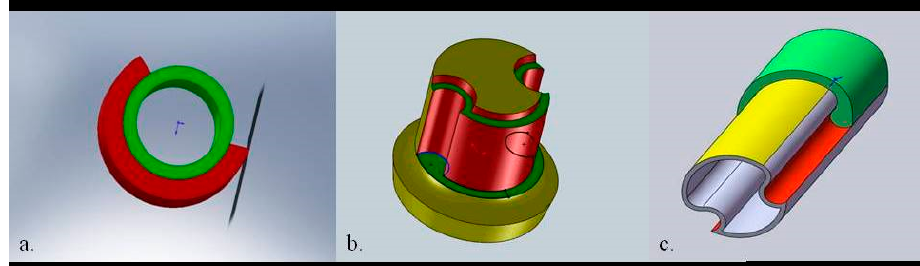
Figure 16. The assembly design (Solidworks) ( a ). Non-retaining “C” shape; ( b ). The design in “ Ω ” of the main Pa structure; ( c ). Functional sliding of ADSP components.